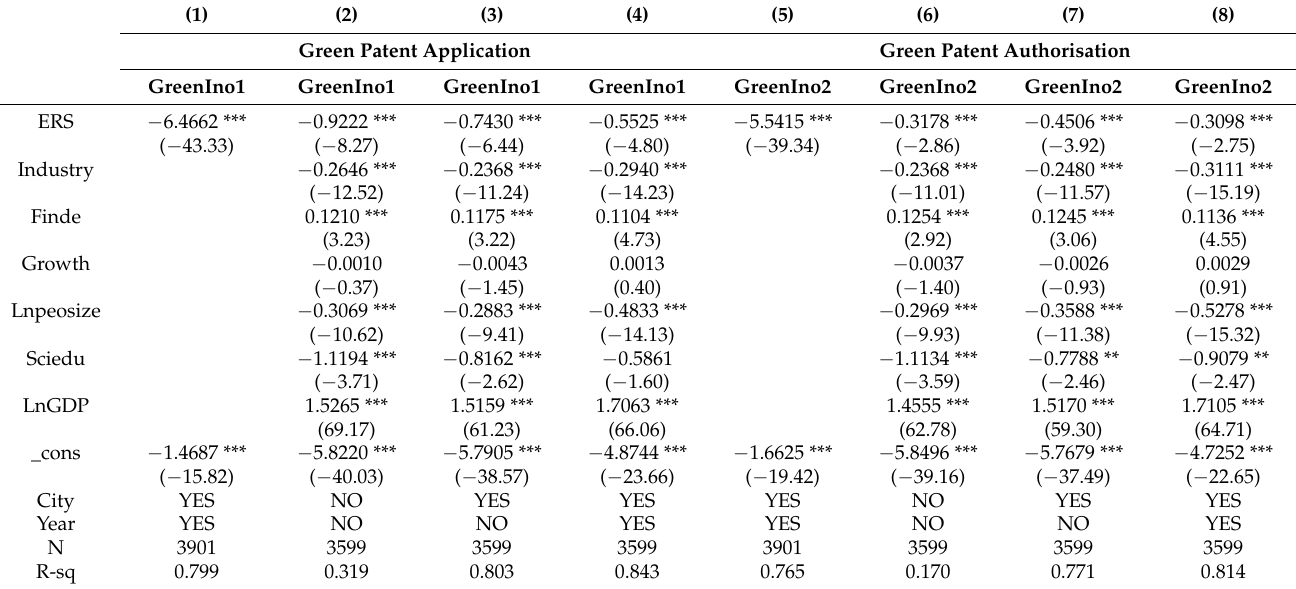
Table 8. Results of robustness tests after dividing green patent into two parts: green patent application and green patent